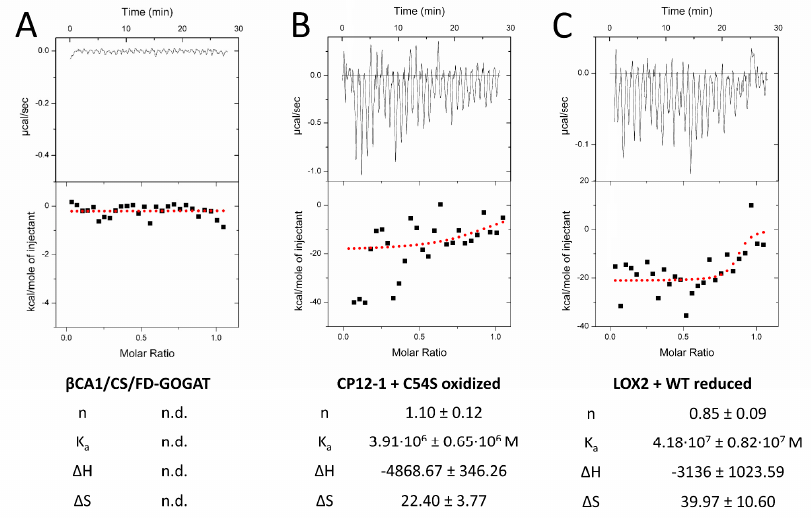
Figure 5. Quantification of the interaction of 2-CysPRX with five interactors by isothermal titration calorimetry (ITC). Recombinant proteins were redox-adjusted and dialyzed for optimal performance. The dialyzed polypeptides were titrated into 2-CysPRXA to circumvent dissociation e ff ects of 2-CysPRX. ßCA1, CS, and FD-GOGAT were not responsive in any variant combination ( A ), while CP12-1 ( B ) and LOX2 ( C ) gave parameters fitting to a weak interaction. Displayed ITC graphs represent one reading, while given values are means of a minimum of four independent measurements. Abbreviations: